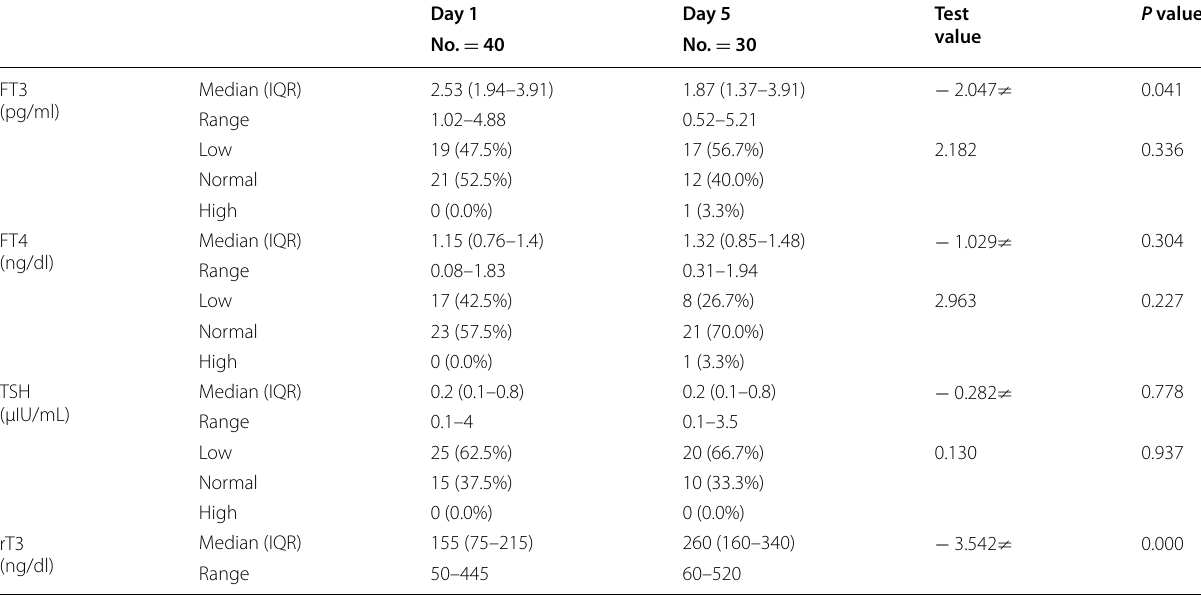
Table 1 Comparison between D 1 and D 5 regarding thyroid hormone levels